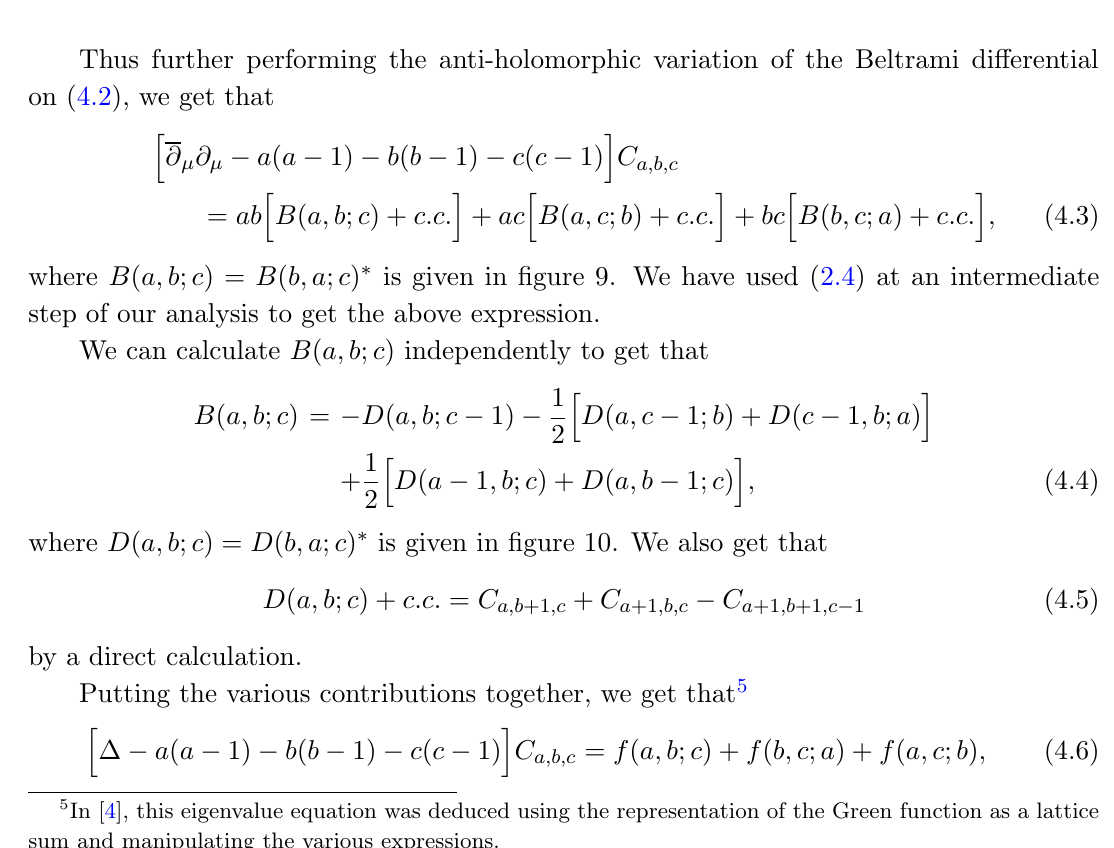
Figure 10 . D ( a; b ; c